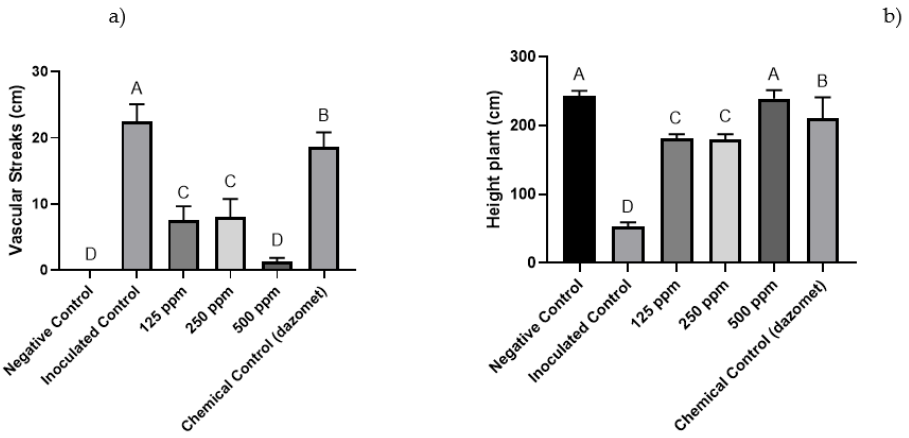
Figure 5. ( a ) Effect of the different concentrations of nanoemulsion (ppm) on the length (cm) of the vascular streaks observed in ‘Naomi’ tomatoes inoculated with Forl (PUCVToF 1667). ( b ) Effect of the different concentrations of nanoemulsion (ppm) on plant height (cm) of ‘Naomi’ tomatoes inoculated with Forl (PUCVToF 1667). Means with different letters indicate significant differences from each other ( p ≤ 0.05).